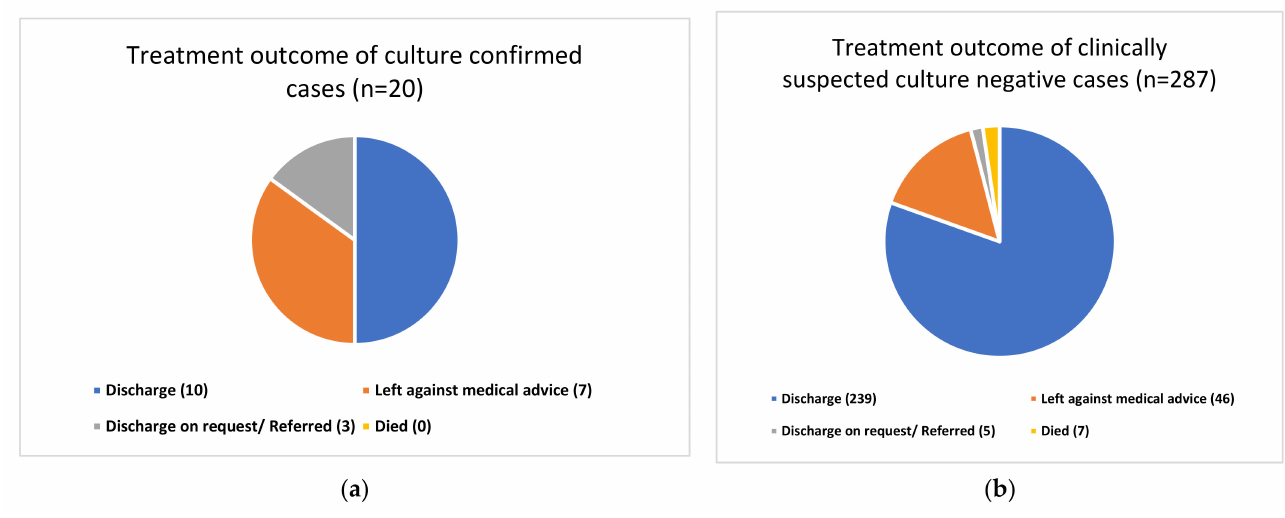
Figure 2. ( a ) Treatment outcome of culture-confirmed cases; ( b ) Treatment outcome of clinically suspected culture-negative